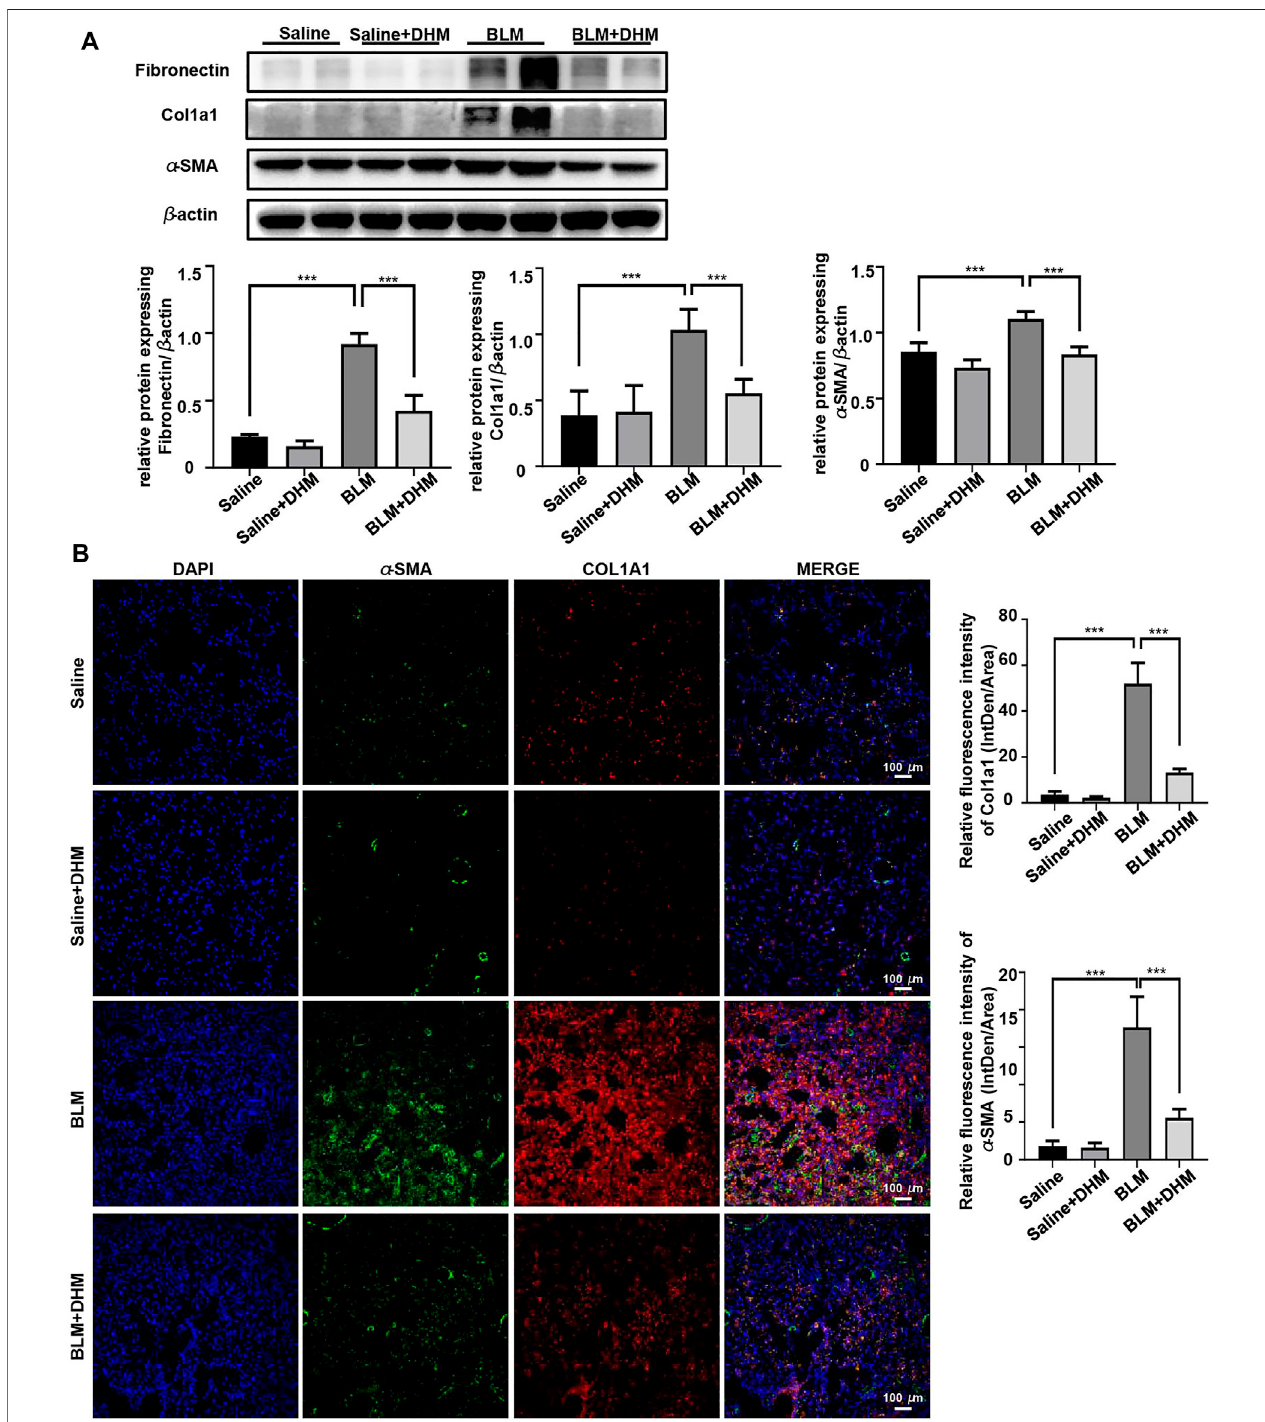
FIGURE5| EffectsofDHMon fi brosismarkersinmiceafterBLMinduction.Saline n =6,DHM n =6,BLM n =6,BLM+DHM n =6. (A) Westernblottinganalysisof fi bronectin,Col1a1,and α -SMAexpressioninthelunghomogenatefromdifferentgroups. (B) CoimmunostainingofCol1a1and α -SMAinthelungsectionsfromdifferent groups. Images were captured at 200 × magni fi cation. The data are represented as the mean ± SD. Ordinary one-way ANOVA analysis was applied. *, p < 0.05; **, p < 0.01; ***, p < 0.001.